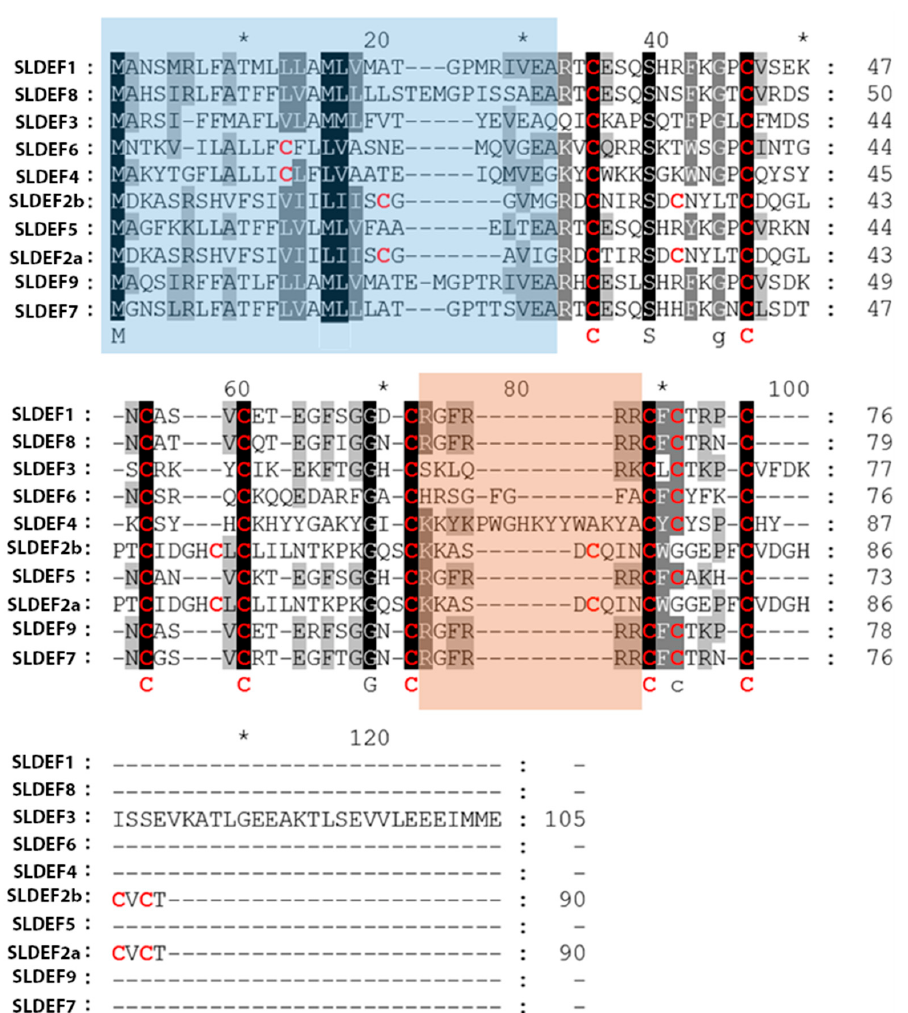
Figure 1. Residues’ alignment reveals a lack of amino acid sequence conservation in tomato plant defensins. Alignment of 10 tomato accessions. The conserved residues are in black-grey boxes, while cysteine residues are in red font. The blue box indicates the transit peptides, as predicted by the TargetP 1.1 Server (http://www.cbs.dtu.dk/services/TargetP/), and the orange box delimits the rich in basic amino acids loop. SlDef: Solanum lycopersicum defensin. * denotes odd number decades. In order to estimate the phylogenetic relationships across accessions, a dendrogram was calculated (Supporting information 4) and two structural clusters were confirmed, also corresponding to peptides having eight and 12 cysteine residues, respectively. Further analyses were performed, explicitly for the mature domains alone, since defensin pro-domains possess no informative structure and can be lost or gained in several instances [23]. Additionally, structure comparison using the Dali server revealed a conserved tertiary structure for tomato defensin proteins despite the extended amino acid discrepancies. The three-dimensional structure of the model (Figure 2) identified the following two chief sections: The N-terminus consisted of a highly conserved beta-strand and α -helix structure, while the C-terminus (that was formed by more disordered structures) contained two beta-strands. Even though the C-terminal was less conserved than the N-terminal, the extra amino acids present in accession SlDEF4 did not significantly alter the strand-coil-strand domain. Furthermore, we generated a sequence profile around the structurally predicted proteins and the resulting stacked residues were depicted against